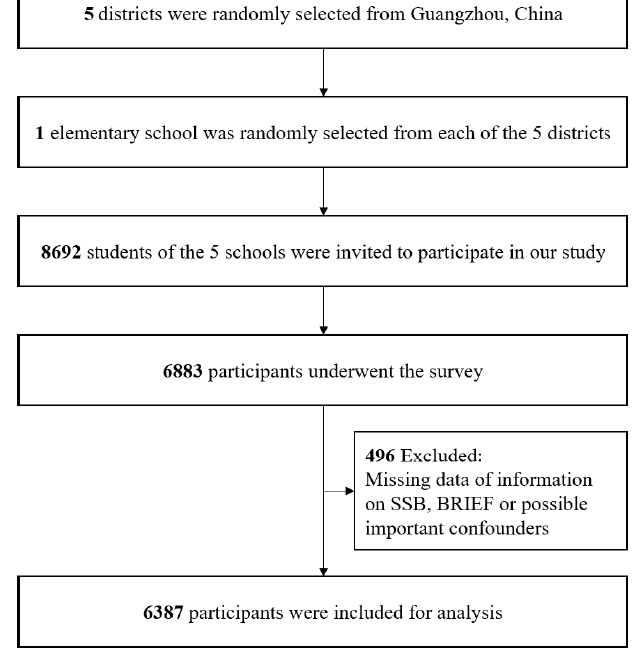
Figure 1. Flowchart of participant inclusion.